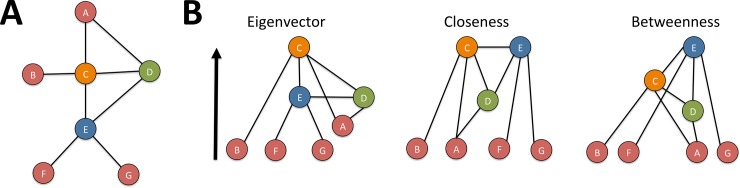
Individual level metrics.(A) an example of a hypothetical social network illustrating the individual level metrics. The letters label individuals in the network.(B) the same network is restructured in a hierarchy such that the node with the highest relevant centrality measure is on top (following the arrow). For example, node C has the highest Eigenvector centrality, but node E had the highest betweenness centrality.